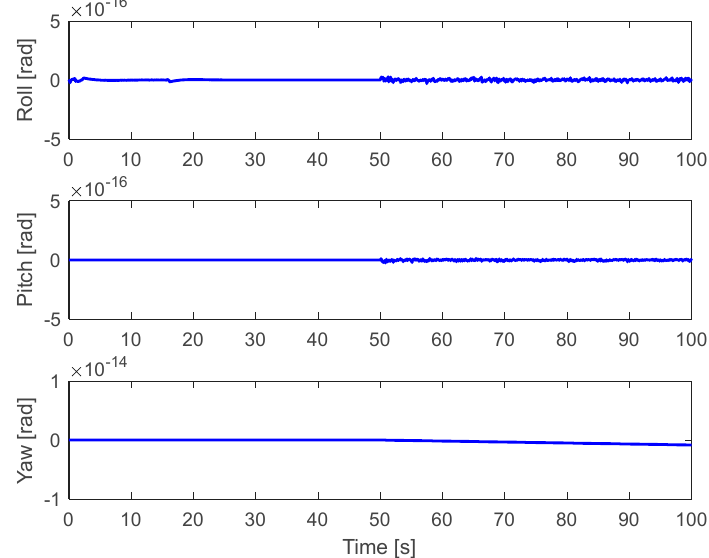
Figure 9. Attitude angle performance with simultaneous fault.